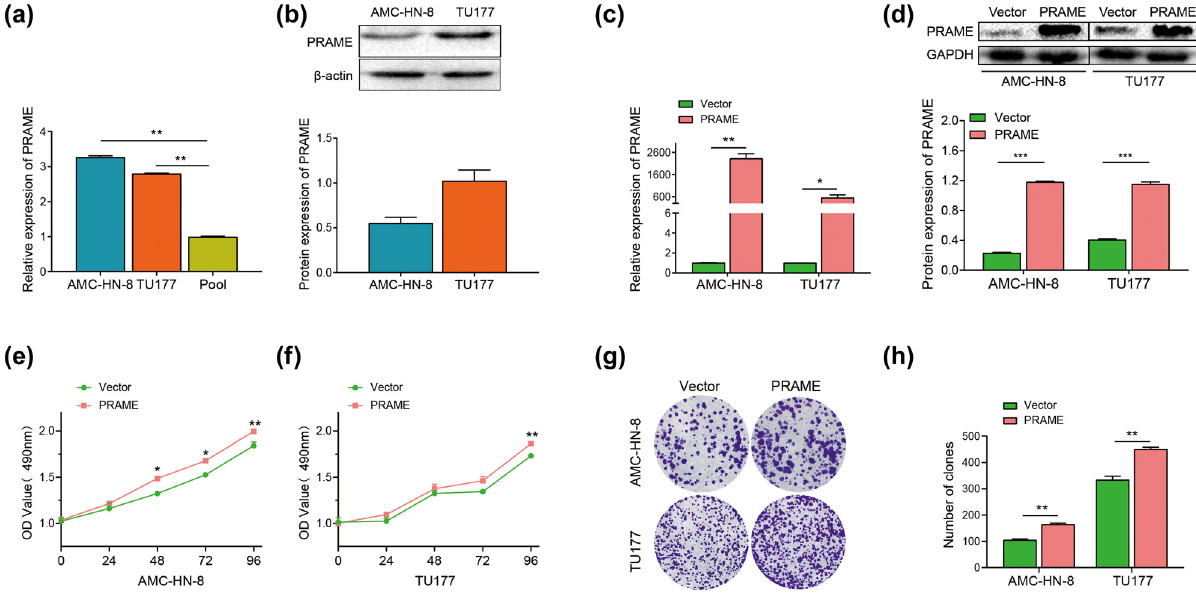
Figure 2: PRAME promotes the proliferation of LSCC cells in vitro . ( a ) PRAME mRNA levels were expressed in AMC - HN - 8 and TU177 via qRT - PCR. ( b ) PRAME protein levels were expressed in AMC - HN - 8 and TU177 via western blot assay. ( c ) The mRNA expression levels of PRAME signi fi cantly increased after the cells were transfected by means of qRT - PCR. ( d ) The protein expression levels of PRAME signi fi cantly increased after the cells were transfected by means of western blot assay. ( e and f ) PRAME obviously enhanced the proliferative capability via MTS assay. ( g and h ) PRAME obviously enhanced the colony formation capability ( * P < 0.05, ** P < 0.01, *** P < 0.001 )